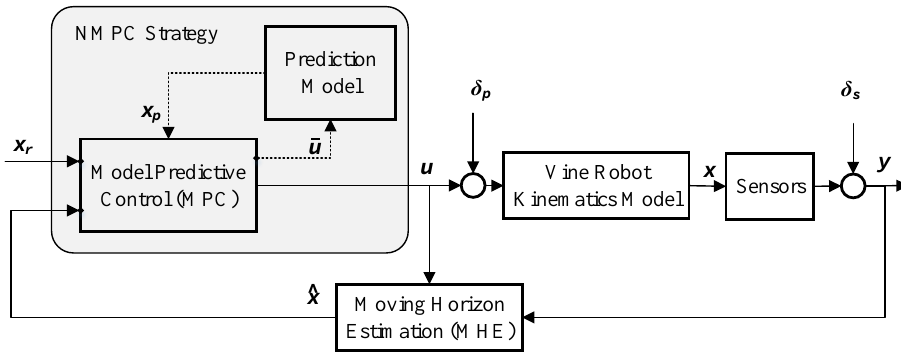
Figure 3. Block diagram of the proposed Model-predictive control (MPC) strategy involved to control the growth of the vine-like growing